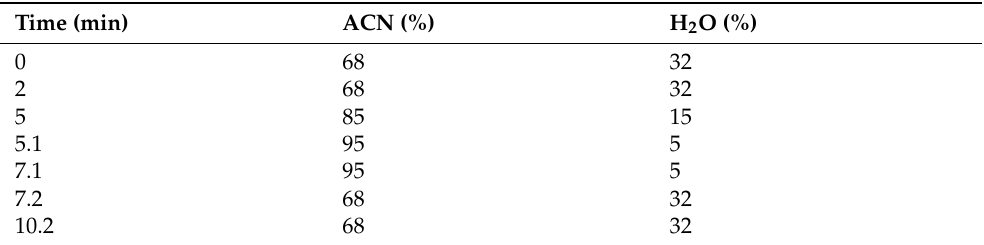
Table 1. Percentage of solvents (water and acetonitrile) during the gradient flow analysis of cy- closporine A using